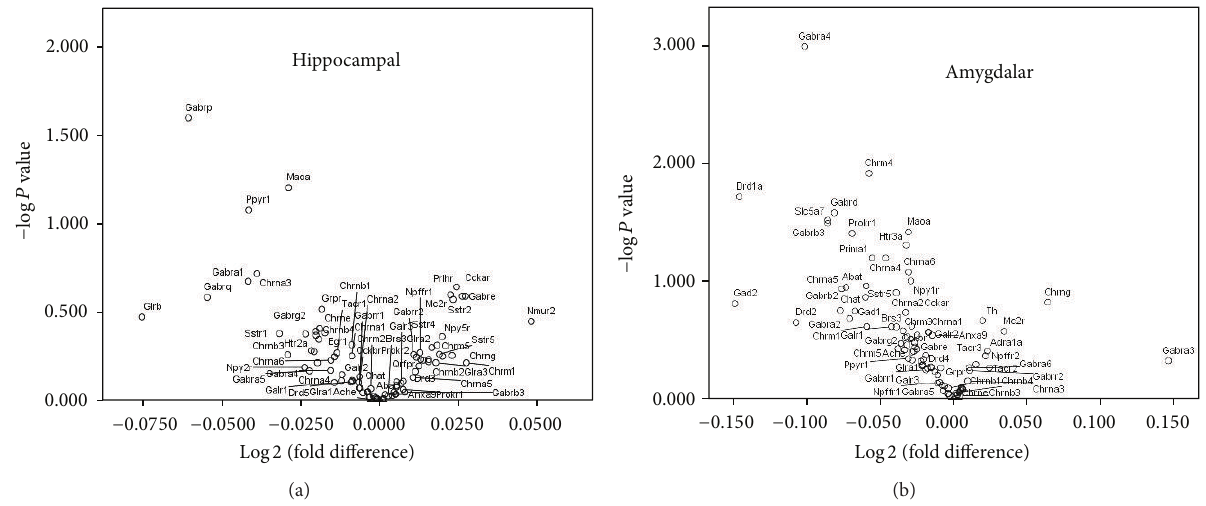
Figure 2: Differential expression of (a) hippocampal and (b) amygdalar mRNA between groups. Volcano plot between Log 2 fold change on the 𝑥 -axis (for neurotransmitter receptors and regulators in L-theanine/midazolam treated groups 40 PTSD-stressed versus 40 nonstressed (control) groups) and − log of 𝑃 value on the 𝑦 -axis. Eighty male Sprague-Dawley rats were injected subcutaneously 30 minutes prior to evaluation of their performance on neurobehavioral tests. The rats were then euthanized and cDNA prepared from the hippocampus (a) and amygdala (b) and were subjected to RT 2 profiler PCR array for rat neurotransmitter receptor and regulator analysis, as described in Materials and Methods. PCR array profiles were performed for the expression of 88 genes potentially involved in PTSD and/or rat neurotransmitter receptors and neurotransmitter regulation.